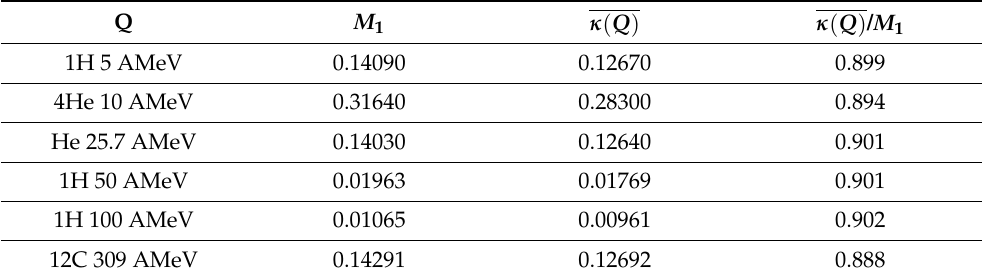
Table 2. Total mean ionization yield M 1 , mean number of ionizations κ ( Q ) due to primary interactions only, and ratio κ ( Q ) / M 1 for several radiation qualities in a target volume of 1